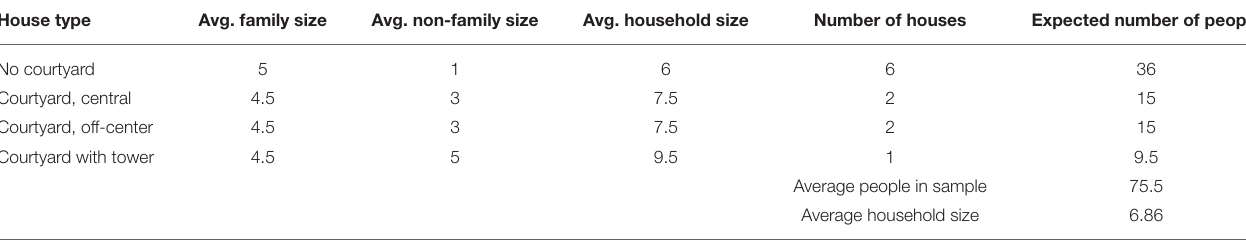
TABLE 5 | Demographic calculations for Metaponto. House